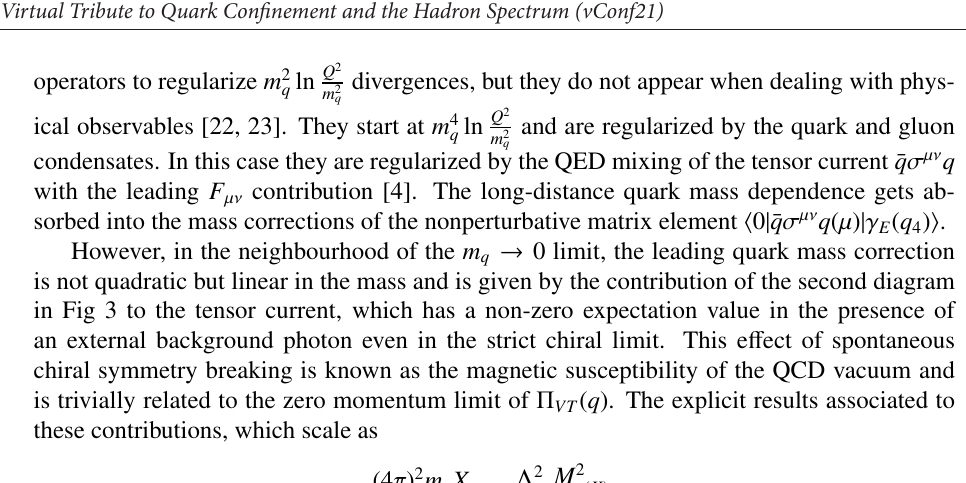
Figure 3. Topologies giving the di ↵ erent contributions to the studied